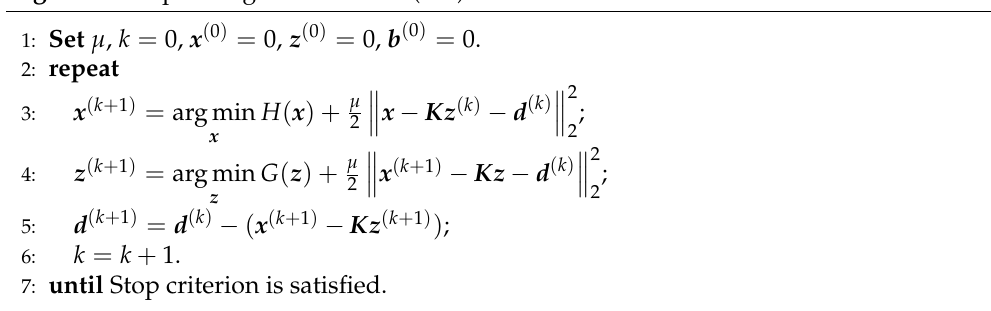
Algorithm 1 Split Bregman Iteration